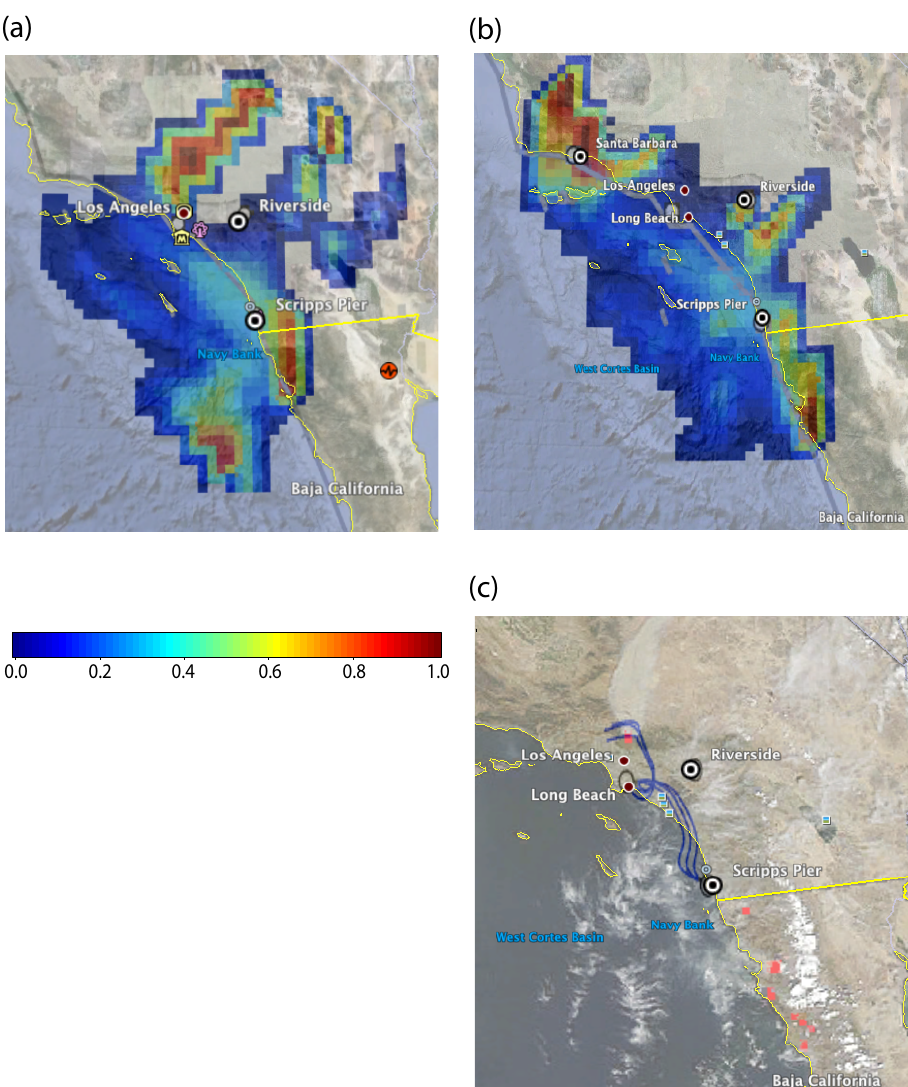
Fig. A1. Potential Source Contribution Function (PSCF) images of (a) the FTIR combustion factor and (b) the FTIR biomass burning factor with warmer colors indicate higher probability. (c) Fire map on 29 August 2009 with red points showing fire spots and blue lines indicating back trajectories ending at the Scripps Pier. The fire image was obtained from NOAA’s Aqua